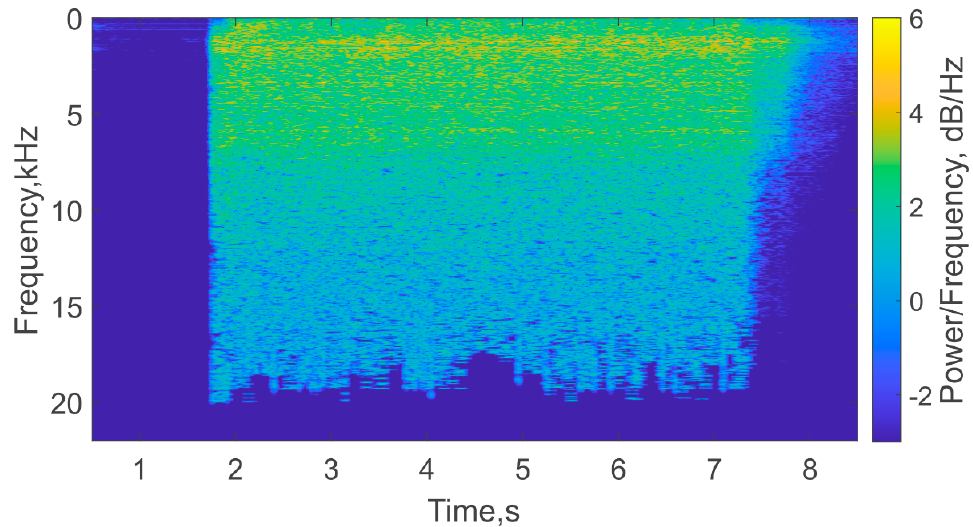
Figure 13. Spectrogram of the audio signal recorded during the experiment.